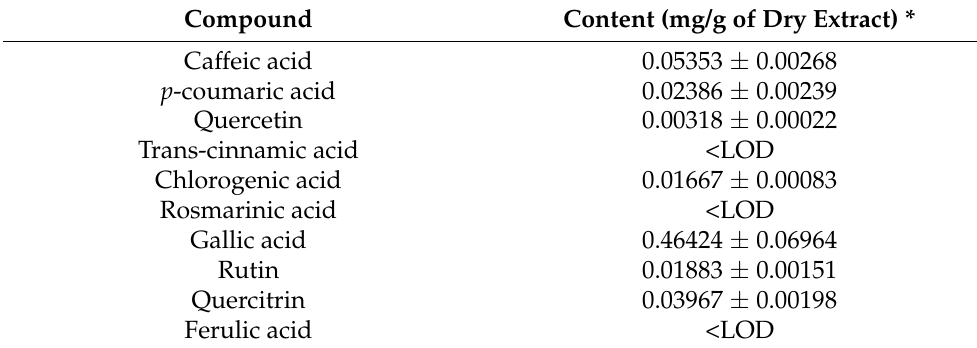
Table 4. Chemical characterization of optimized carob pulp extract—phenolic